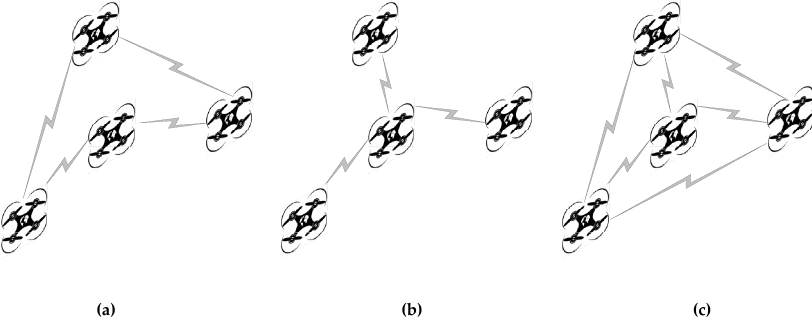
Figure 2. Schematic showing a single-group swarm Ad hoc network.